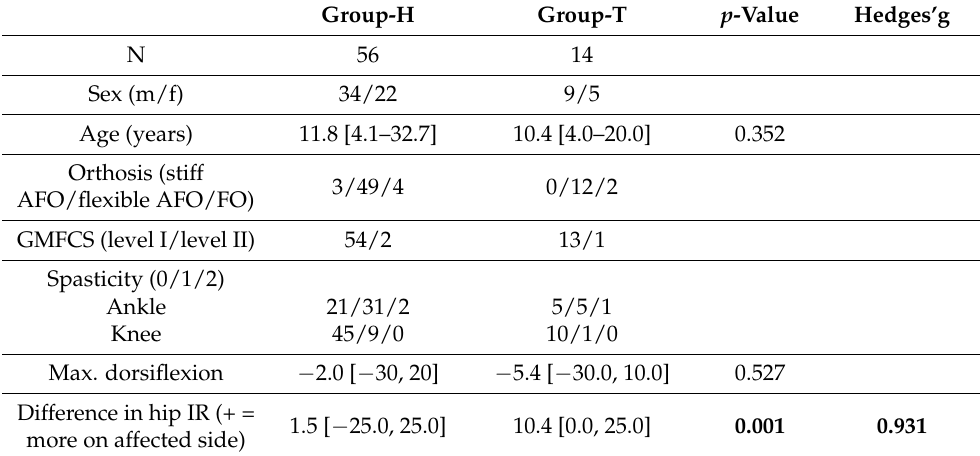
Table 1. Description of the patient cohorts and overview of results. Group-H: Patients who achieved a heel-toe gait and wore the orthosis regularly ( ≥ 8 h a-day), Group-T: Patients who remained toe-walking. They either rejected the orthosis, wore it only for a short time per day (< 8 h per day), or walked on the toes despite the orthosis, GMFCS: Gross Motor Function Classification Scale, AFO: Ankle Foot Orthosis, FO: Foot Orthosis, IR: Internal Rotation. As spasticity (modified Ashworth) was only measured as part of the clinical exam prior to gait analysis, the total number is lower than the total number of the group. Results reported as mean [min, max]. Negative values for the maximum dorsiflexion indicate an equines